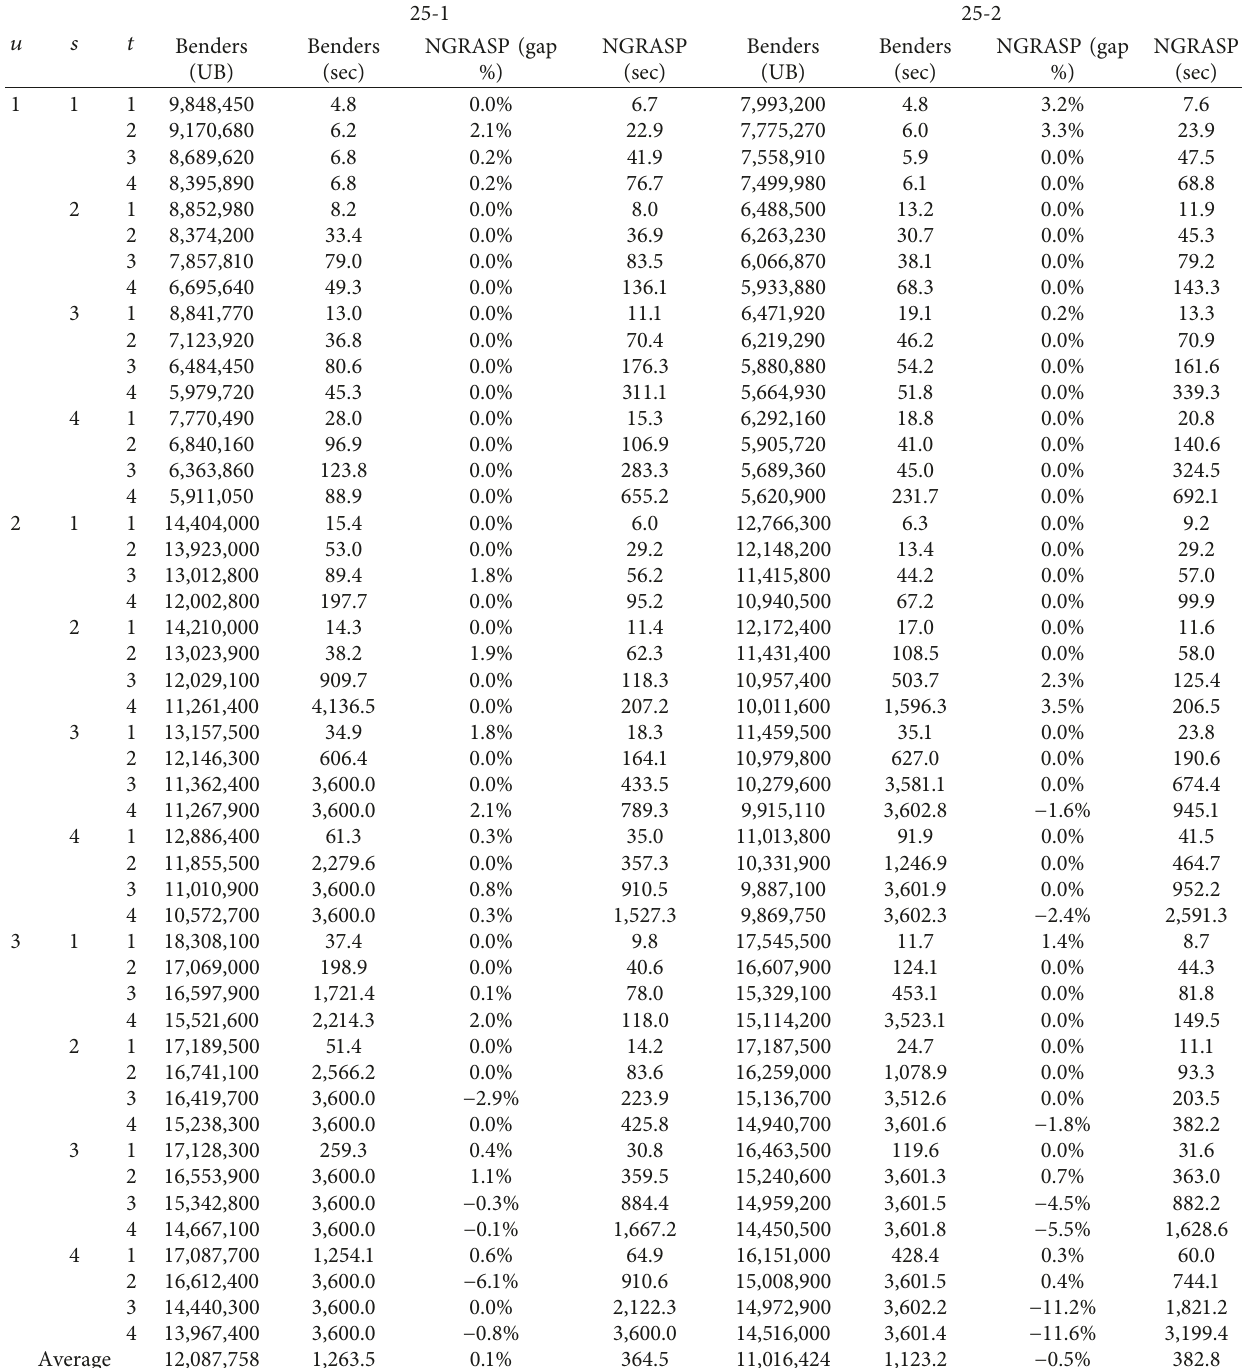
Table 7: Computational results on 25-node